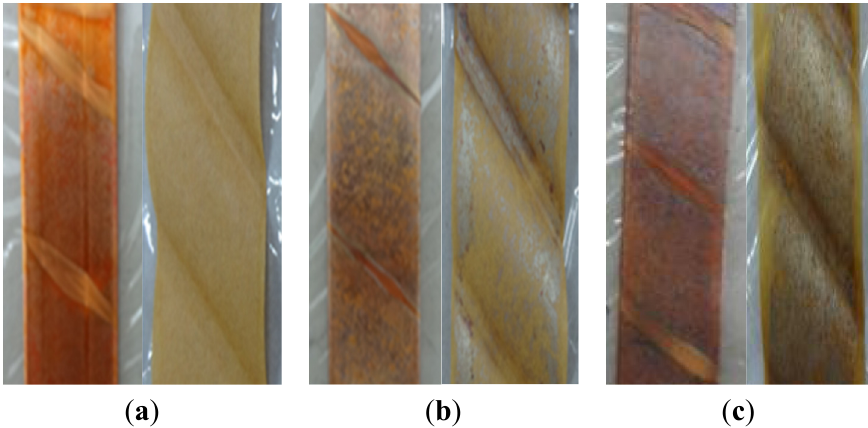
Figure 2. Appearance of copper and paper surface of samples ( a ) sample I; ( b ) sample II; and ( c ) sample